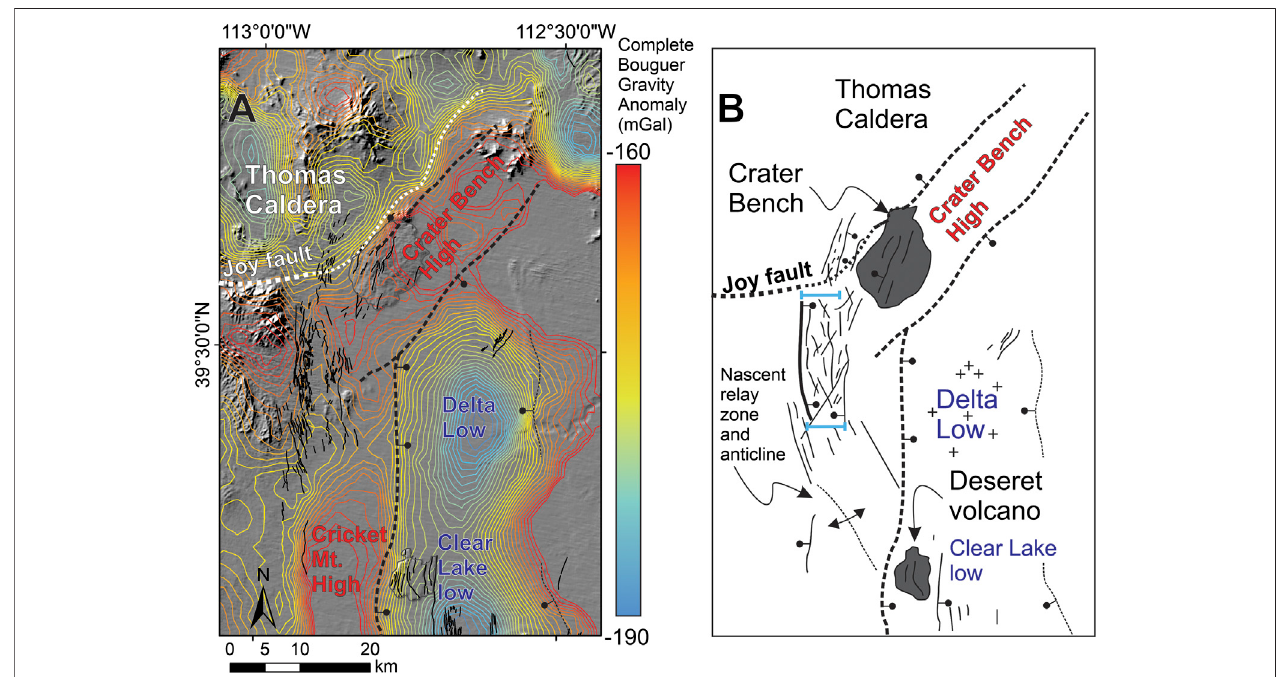
FIGURE11|(A) CompleteBouguergravityanomalymapwithQuaternaryfaultsand (B) aschematicinterpretationofthepatternoffaulting (B) .ThetraceoftheJoy fault — a caldera collapse fault of Oligocene age (Dommer, 1980) — is shown in white dashed line (thick where mapped and thin where inferred). Light blue lines in (B) demarcate the position and width of a negative gravity anomaly within the DMFZ and bounded by highs of Crater Bench and Drum Mountains to the east and west, respectively. Plus symbols in (B) indicate signi fi cant accumulations of evaporites in the subsurface. Our interpretation of the DMFZ is that it accommodates extension between a graben in the eastern Sevier Desert (prominent gravity lows near Delta and Clear Lake) and an obliquely trending horst under Crater Bench (HardwickandChapman,2011).ThesubtleshiftsinfaultorientationalongtheDMFZcanbeattributedtotheformationofarelayzoneandanticlineinthesouthandnorth, as well as the reactivation of older, predominant fault sets observed in the Drum Mountains (Crittenden, 1961; Dommer, 1980). In the north, the rim of the caldera may also control fault orientations.